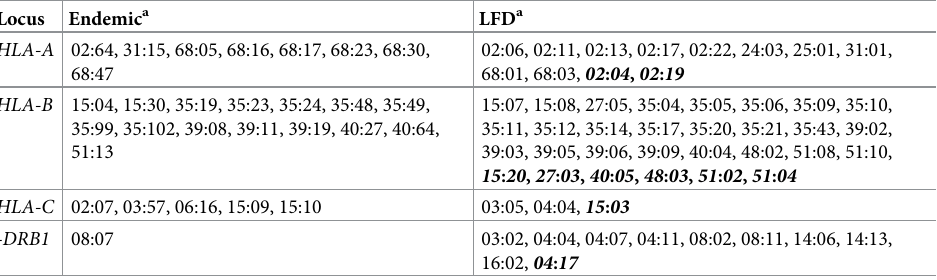
Table 5. Alleles classified as endemic or "large frequency difference" (LFD). Locus Endemic a LFD